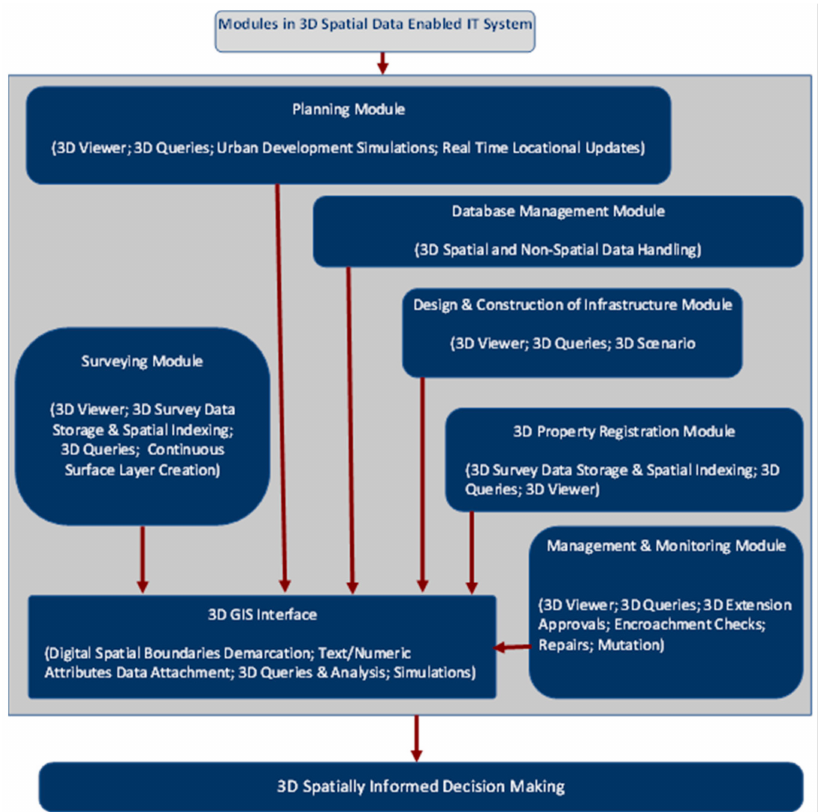
Figure 8. Proposed 3D enabled modules of IT framework for spatially informed decision